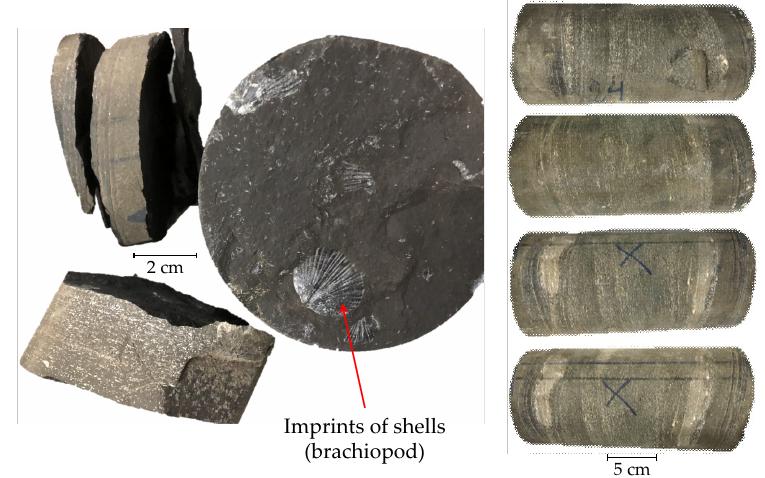
Figure A1. 3D view photo of the whole core #545.